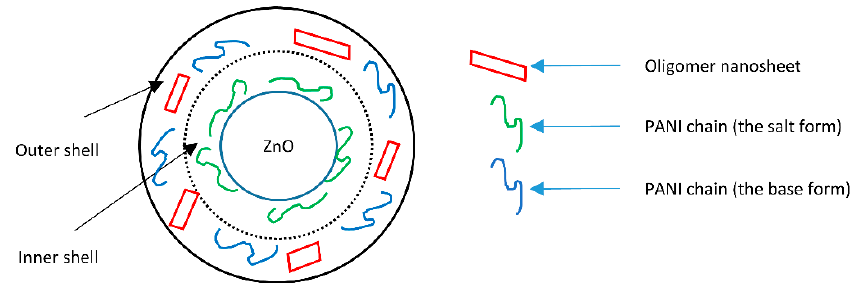
Figure 5. FE-SEM image of PANI/ZnO_3 composite. Image shows that lamellas are assembled by π – π stacking of small oligomers. The ZnO particles are trapped within lamella formations.